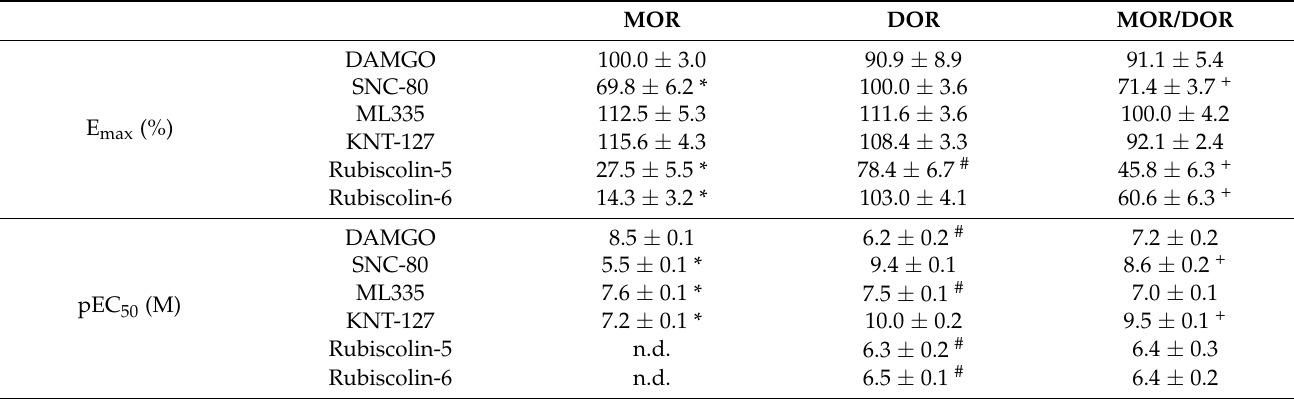
Figure 6. Changes in intracellular cAMP levels induced by rubiscolin-5, rubiscolin-6, and opioid compounds. Cells expressing MOR ( A ), DOR ( B ), or MOR/DOR ( C ) were treated with the listed compounds (10 − 11 –10 − 5 M), and the intracellular cAMP levels were measured with the cADDis ® cAMP assay. Concentration–response curves were prepared by calculating cAMP levels relative to the data obtained with 10 − 5 M DAMGO for MOR ( A ), 10 − 5 M SNC-80 for DOR ( B ), and 10 − 5 M ML335 for MOR/DOR ( C ). Data are presented as means ± S.E.M. for three independent experiments ( n = 6–8). Table 2. E max and pEC 50 values for rubiscolins and opioid compounds obtained in the cAMP assay for MOR, DOR, and MOR/DOR. MOR DOR